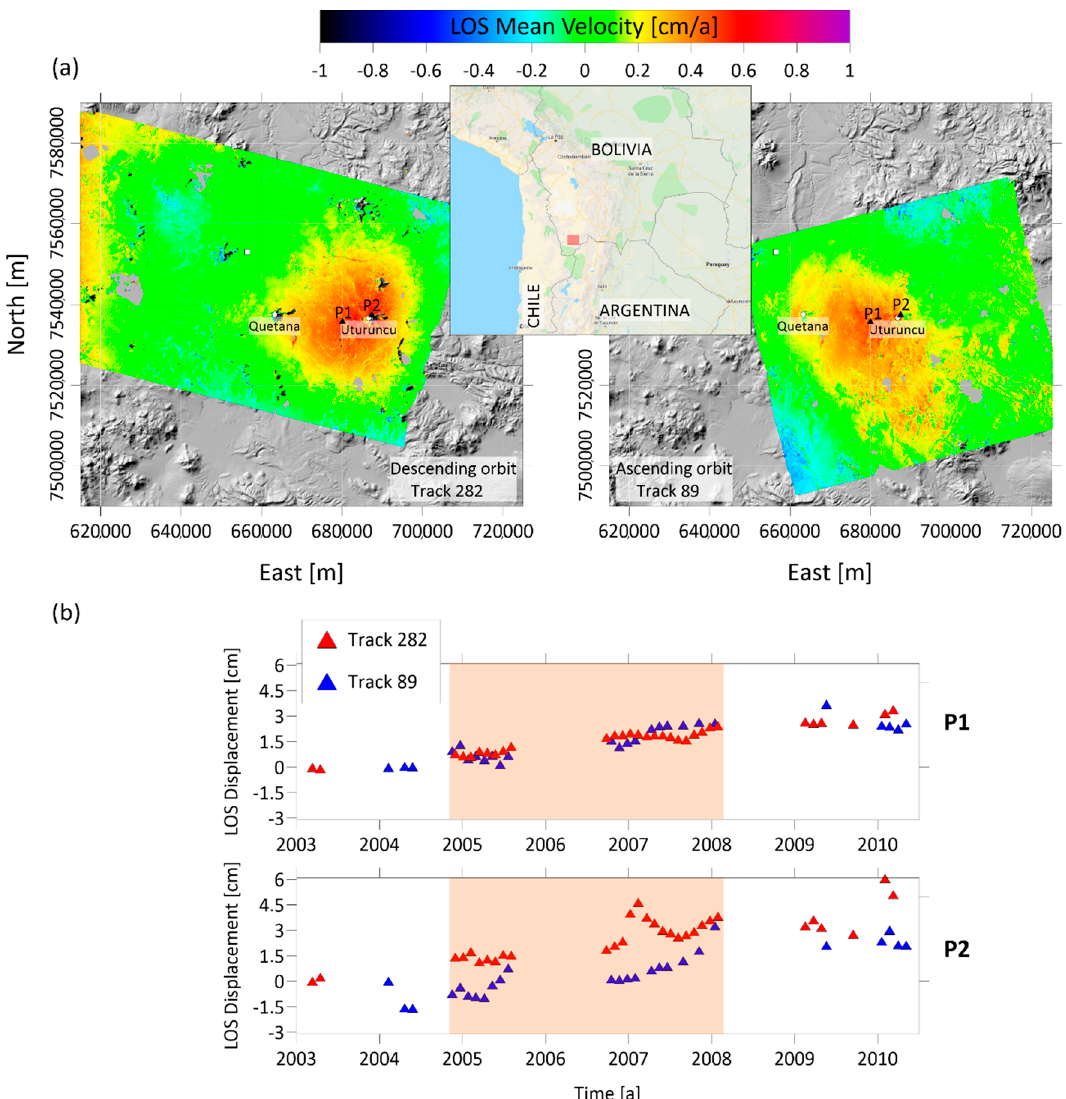
Figure 1. DInSAR measurements of APVC and Uturuncu volcano. ( a ) LOS mean velocity maps (cm/a) retrieved by ENVISAT satellite data acquired along ascending (right-track 89) and descending (left-track 282) orbits, superimposed on Shuttle Radar Topography Mission (SRTM) Digital Elevation Model (DEM); the reference map (Google Maps source) in upper center shows the study area location (red box); the white solid square shows the reference point, the white solid circles indicate the Uturuncu and Quetana volcanoes location, while the solid black triangles show the location of the selected P1 and P2 pixels; ( b ) LOS displacement time-series (cm) related to the 2003–2010 interval at the P1 (up) and P2 (down) pixels; the blue and red triangles represent the time-series related to the tracks 89 and 282, respectively, while the light red rectangle indicates the considered 2005–2008 time interval for the following analysis.